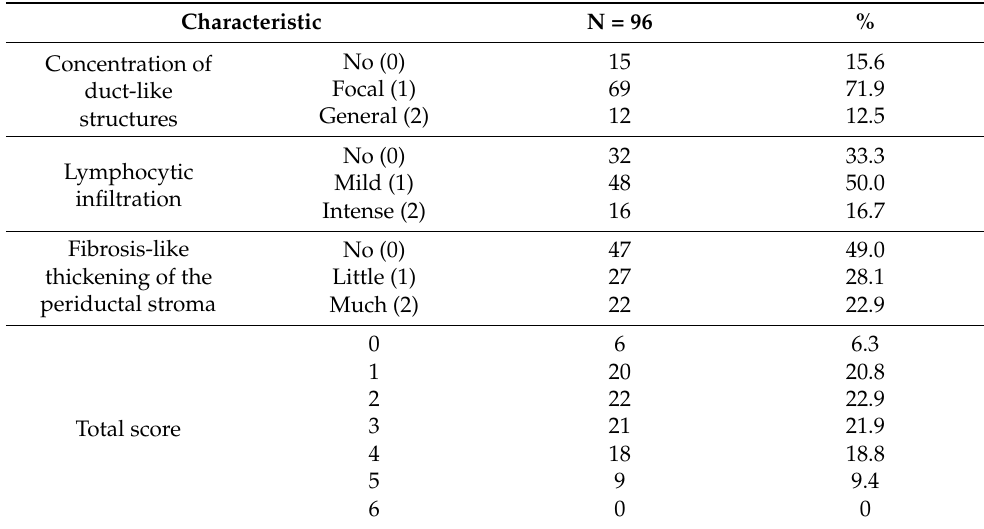
Table 1. Histopathological signs of neoductgenesis, the number and percentage distribution of individual features and the distribution of the sum of points obtained in the